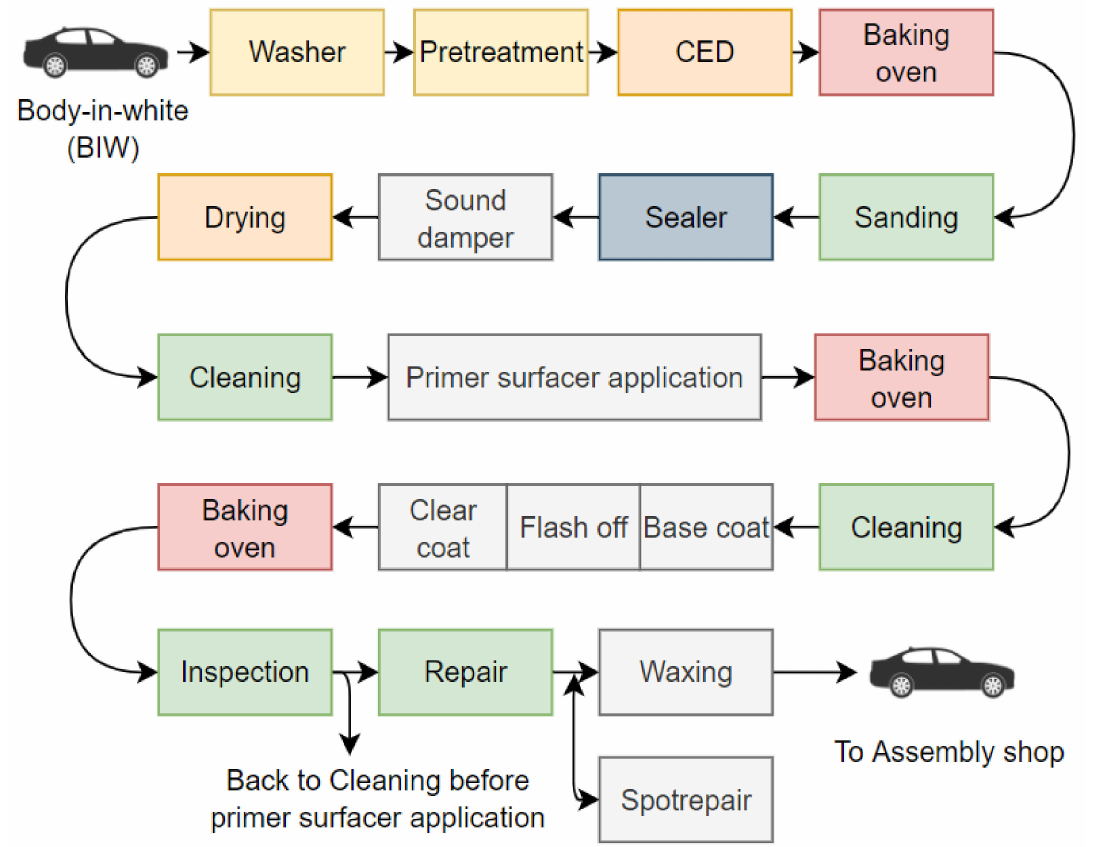
Figure 2. The steps of a process in the automotive paint shop, adapted from